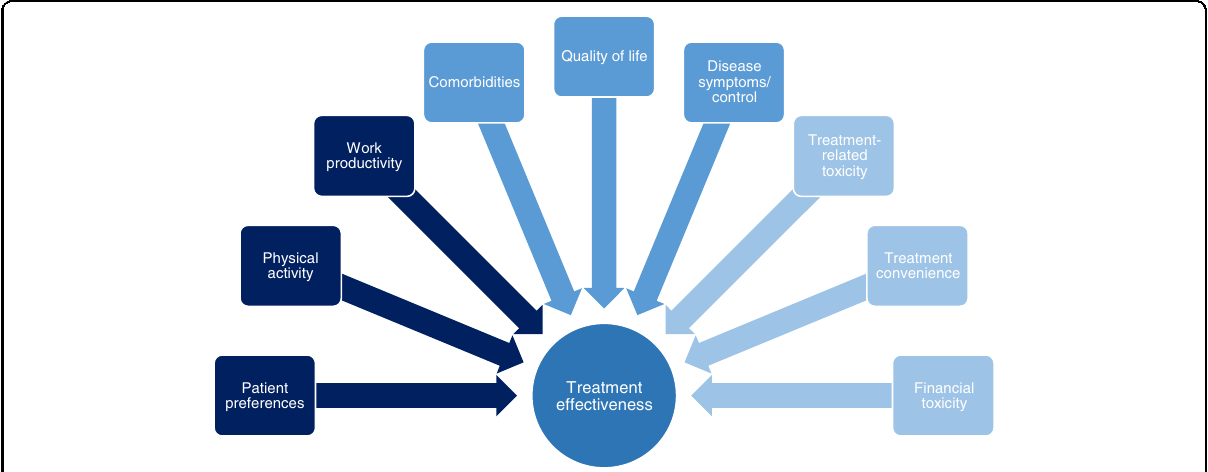
Fig. 1 Treatment factors of importance to MM patients. There are multiple factors of importance to MM patients regarding their treatment that impact on the effectiveness of that treatment in the real-world